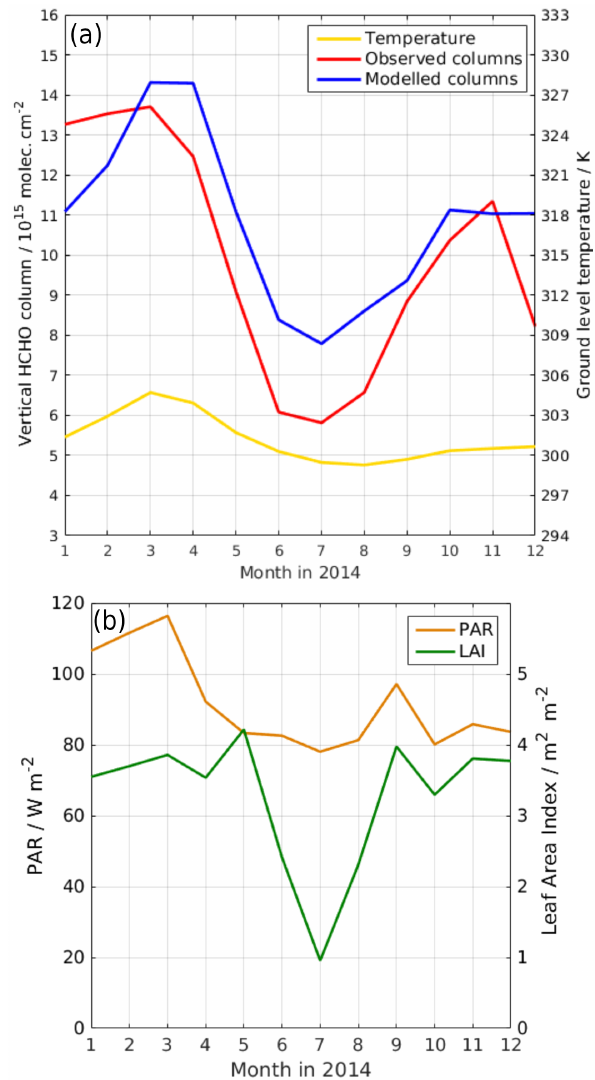
Figure 10. Time series of (a) monthly mean OMI and GEOS- Chem vertical HCHO columns (10 15 moleccm − 2 ), and GEOS-FP ground-level temperature; and time series of (b) PAR (Wm − 2 ) and LAI (m 2 m − 2 ) over the state of Kerala in